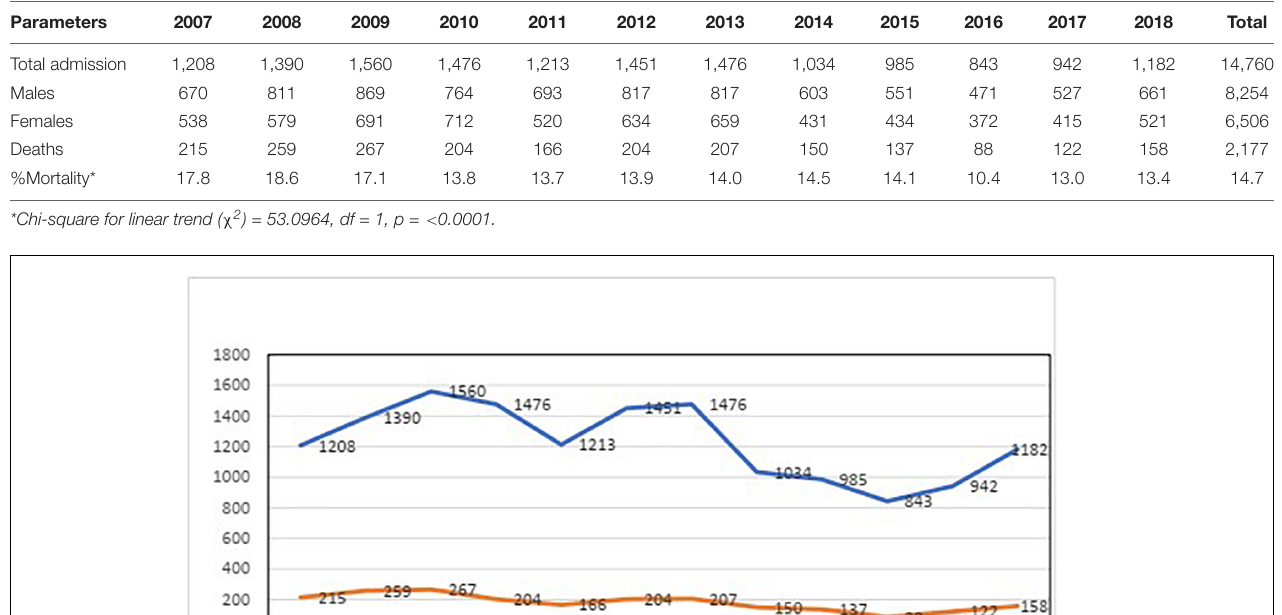
TABLE 1 | Summary of newborn admissions and outcomes (2007–2018).